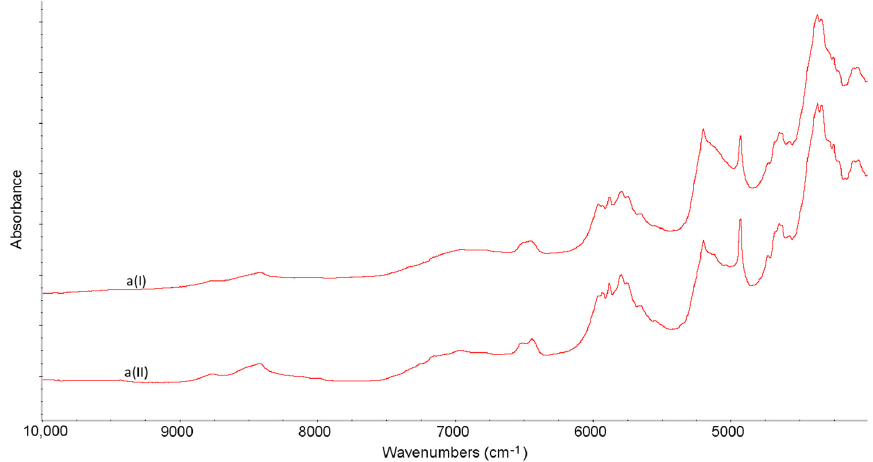
Figure 7 . NIR spectra for linagliptin (a) in the non-stressed (I) and stressed (II) samples.